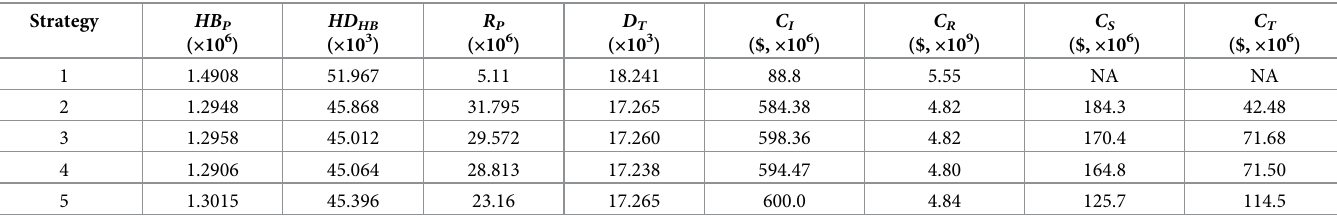
Table 3. Population stats in Brazil in 2027 under five different strategies.